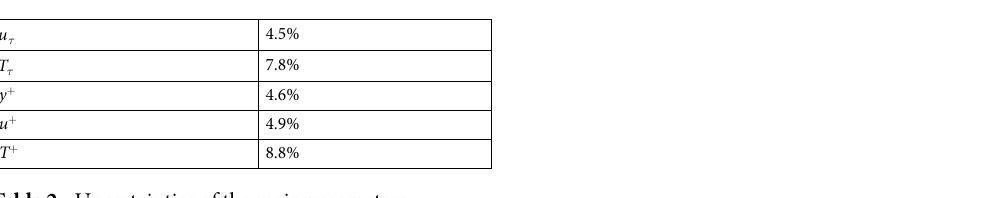
Figure 5. The calibration surfaces. ( a ) The calibration surface of u ; ( b ) The calibration surface of T .